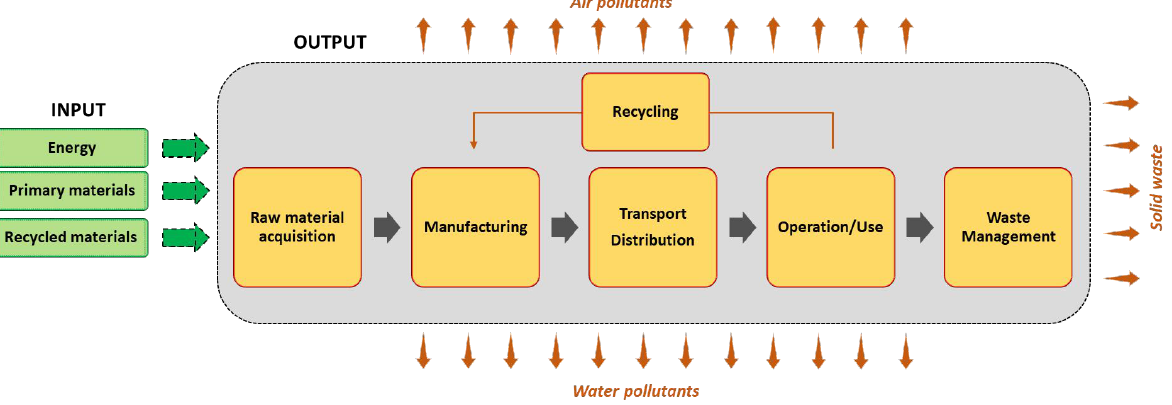
Figure 3. Flowchart of the generalized LCA method.